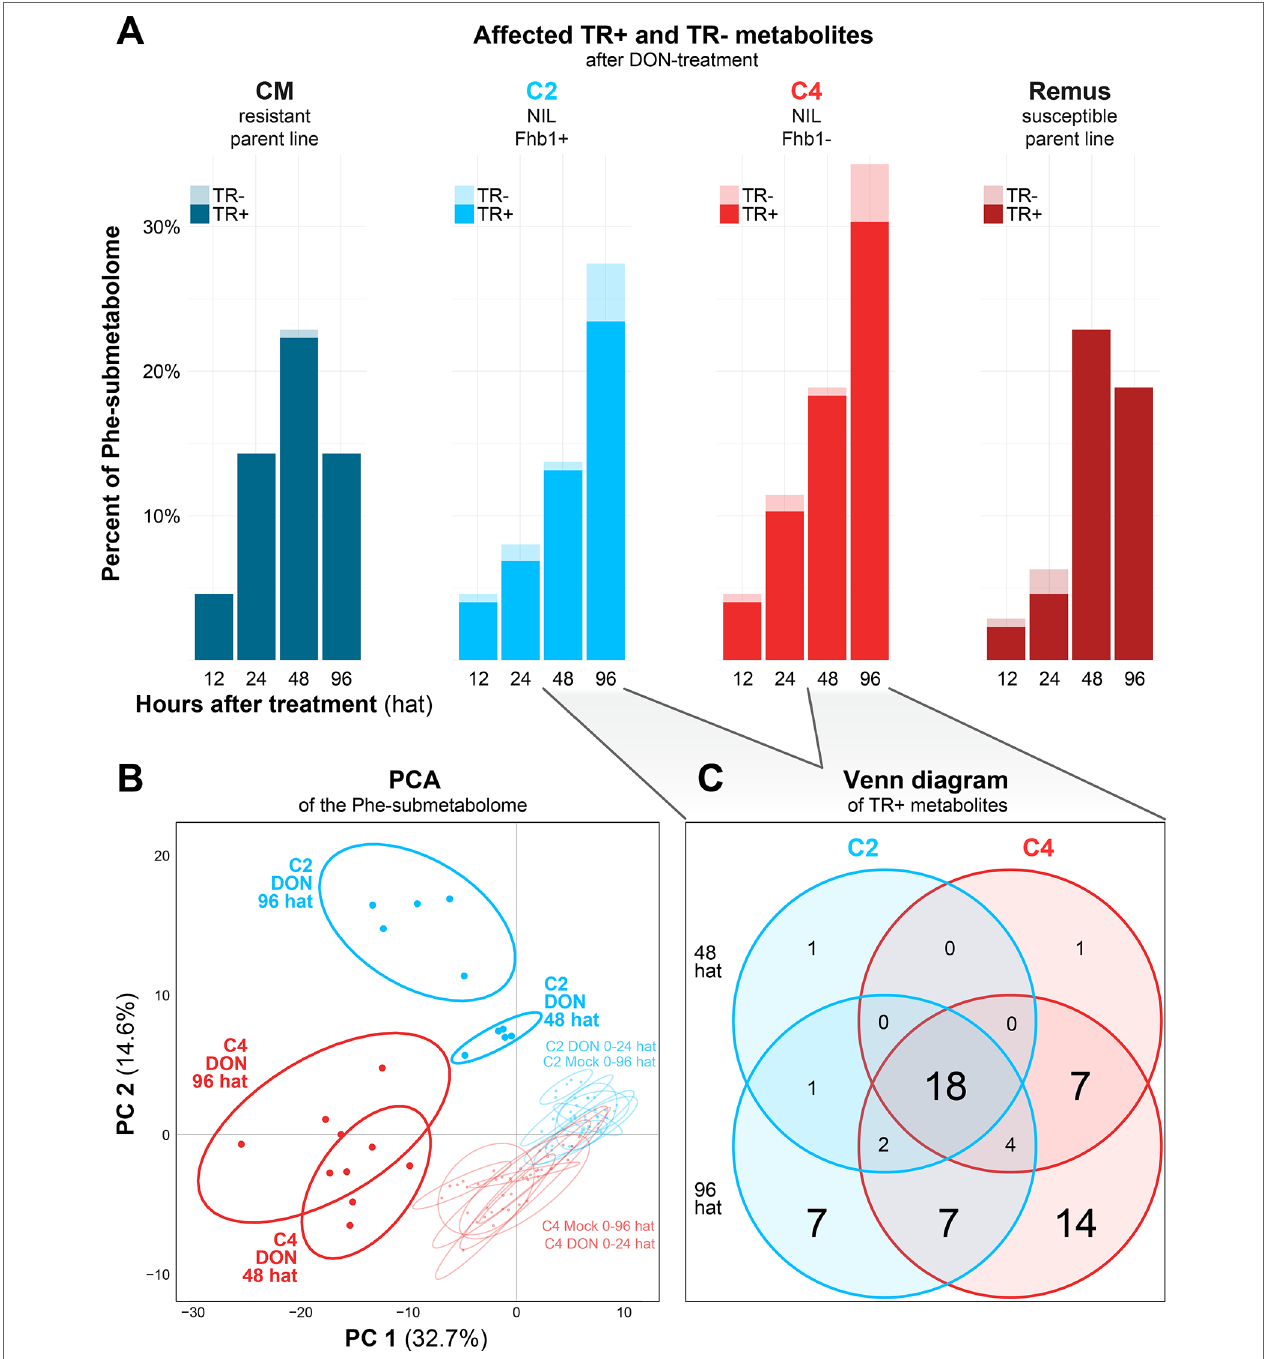
FIGURE 3 | (A) Histogram of Phe-derived metabolites with significantly differing abundance levels in the DON-treated groups over time for each of the four tested wheat lines. (B) Scores plot of the PCA for the C2 and C4 genotypes based on the metabolite profiles of the DON and mock treatments. (C) Venn diagram of metabolites classified as TR+ in C2 and C4 at 48 and 96 h after DON